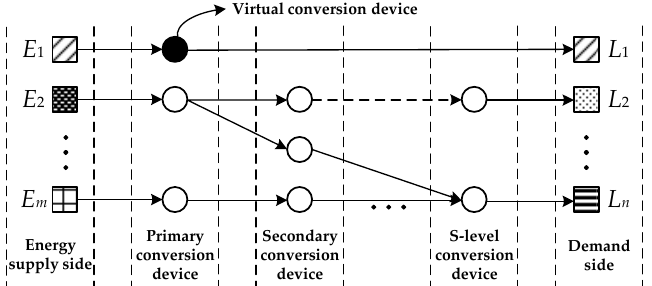
Figure 5. Schematic diagram of the hierarchical structure of a complex ECI.